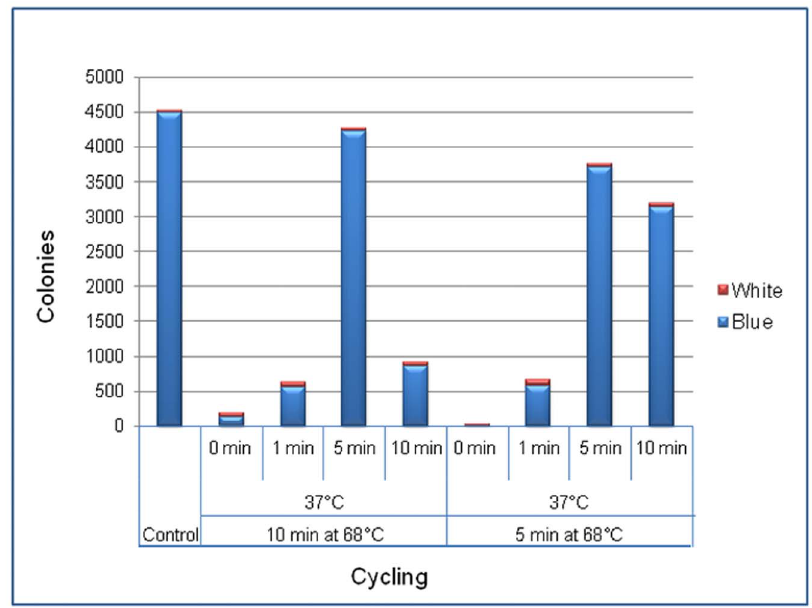
Fig. 9. Comparison study of Hot Fusion under different cycling conditions. A full lacZ gene with overlapping sequences to a vector was amplified and used for testing. The same amount of linearized base vector and lacZ insert were used in each reaction. The vector and insert were mixed and incubated at 37 ˚ C for 0, 1, 5 or 10 minutes, respectively, and then switched to 68 ˚ C for 5 or 10 minutes, respectively. The control used the regular Hot Fusion condition (1-hour at 50 ˚ C) as described in the Materials and Methods. Blue and red bars indicate numbers of clones containing either the lacZ gene or empty vector,